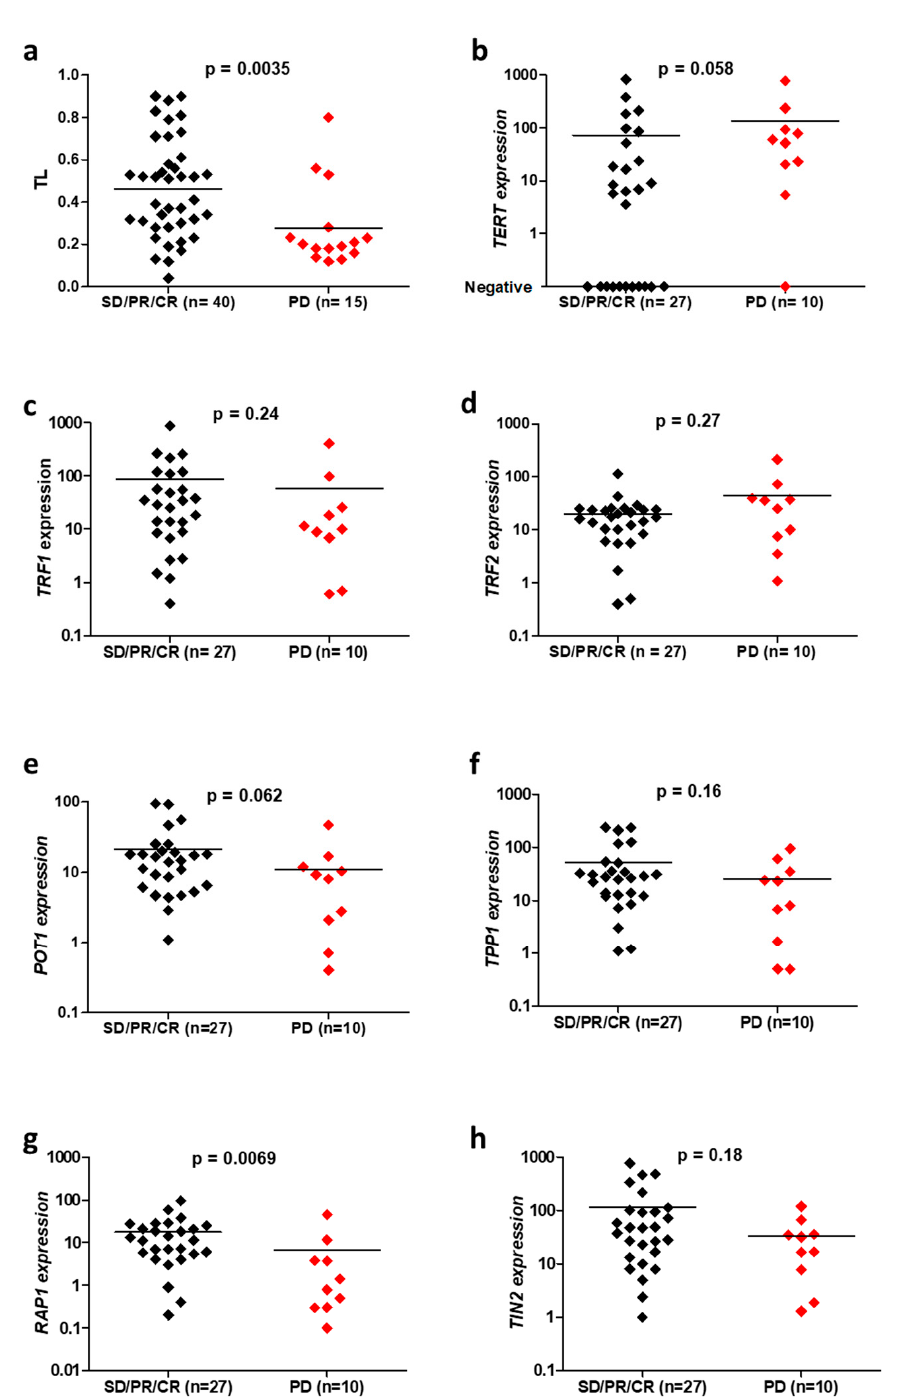
Figure 1. Comparison of telomeric parameters, including telomere length (TL) ( a ), TERT ( b ), TRF1 ( c ), TRF2 ( d ), POT1 ( e ), TPP1 ( f ), RAP1 ( g ) and TIN2 ( h ) expressions, depending on the response to the first-line chemotherapy for advanced NSCLC, in accordance with RECIST 1.1 criteria: progressive disease (PD) versus stable disease (SD), partial response (PR) or complete response